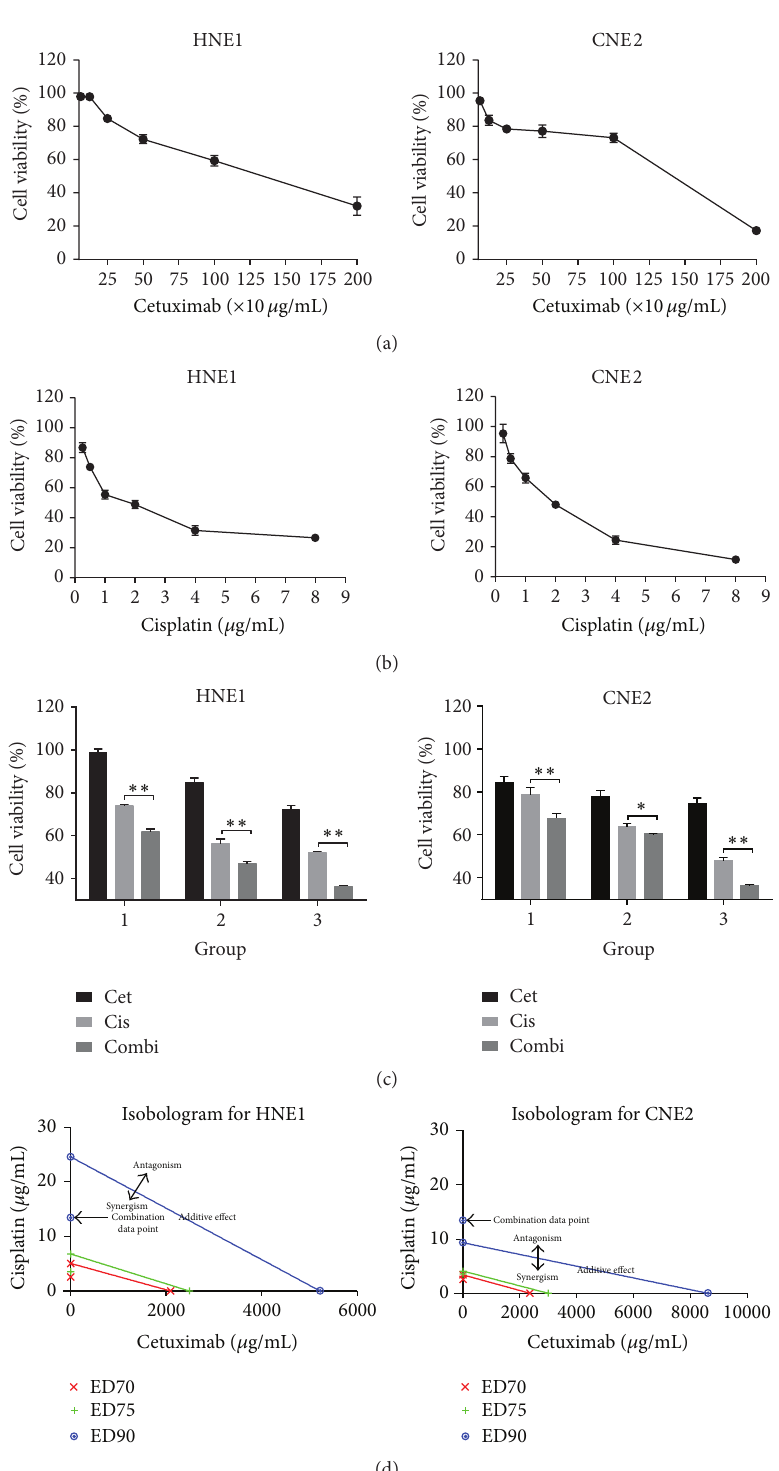
Figure 1: Effects of cisplatin, cetuximab, and a combination of both on NPC cell growth. HNE1 and CNE2 cells were treated with the indicated concentrations of (a) cetuximab, (b) cisplatin, or (c) 1 𝜇 g/mL cisplatin and 250 𝜇 g/mL cetuximab for 48h, and cell viability was determined by a CCK-8 assay. (d) The classic isobologram of HNE1 and CNE2 cells. ∗ 𝑝 < 0.05 , ∗∗ 𝑝 < 0.01 versus cisplatin treatment